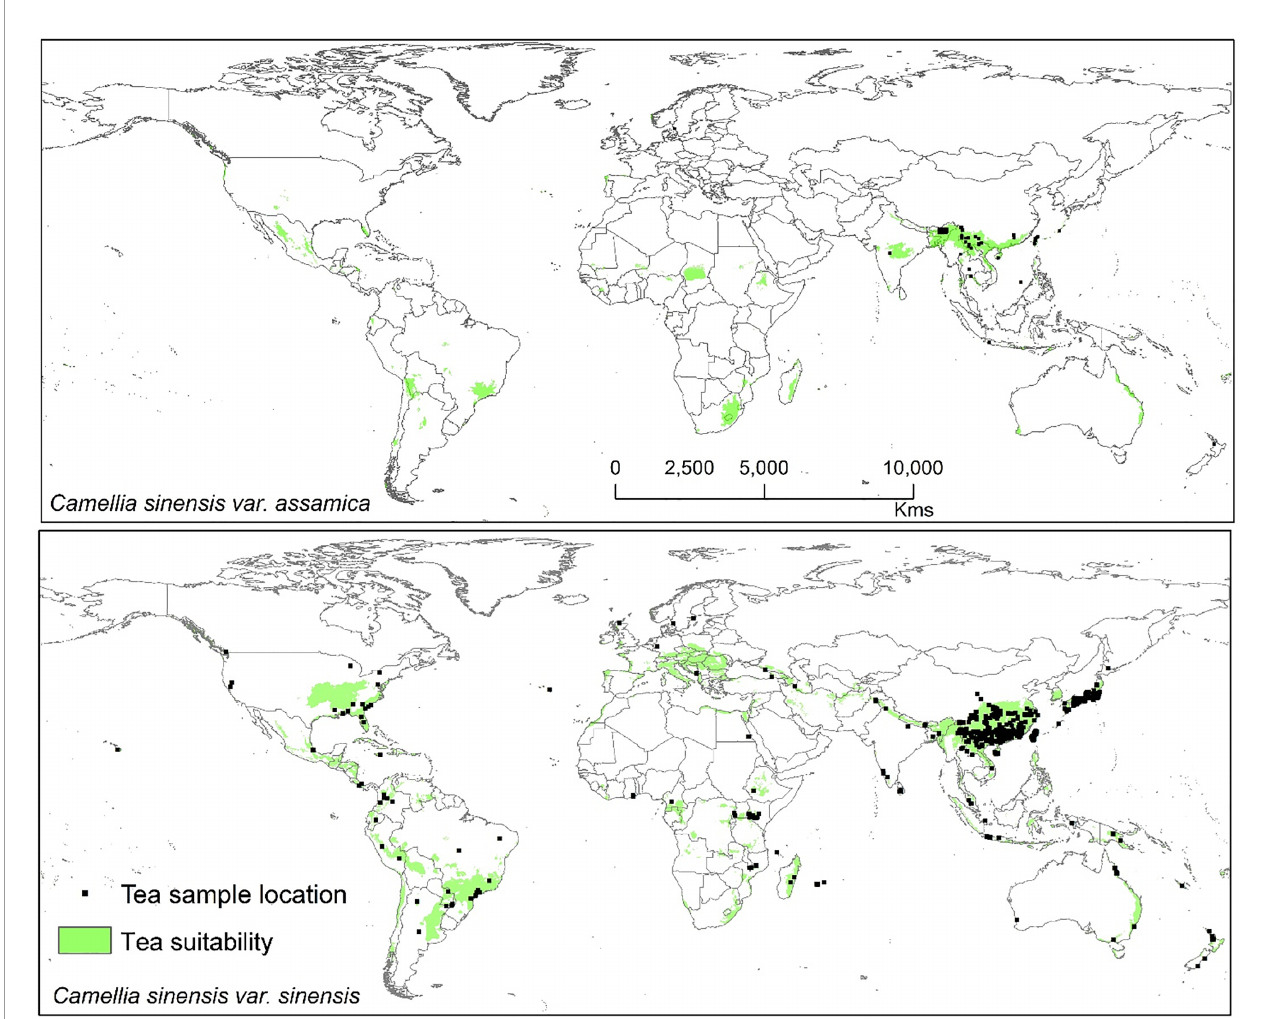
FIGURE 1 | Suitable area for C. sinensis var. sinensis and C. sinensis var. assamica growing in baseline climatic conditions (green represents the suitable areas). Tea species occurrence records by different plant collectors and deposited in various herbaria across the world. Here locations of species occurrence records are plotted, and in the background tea-suitable area in baseline climatic scenario is